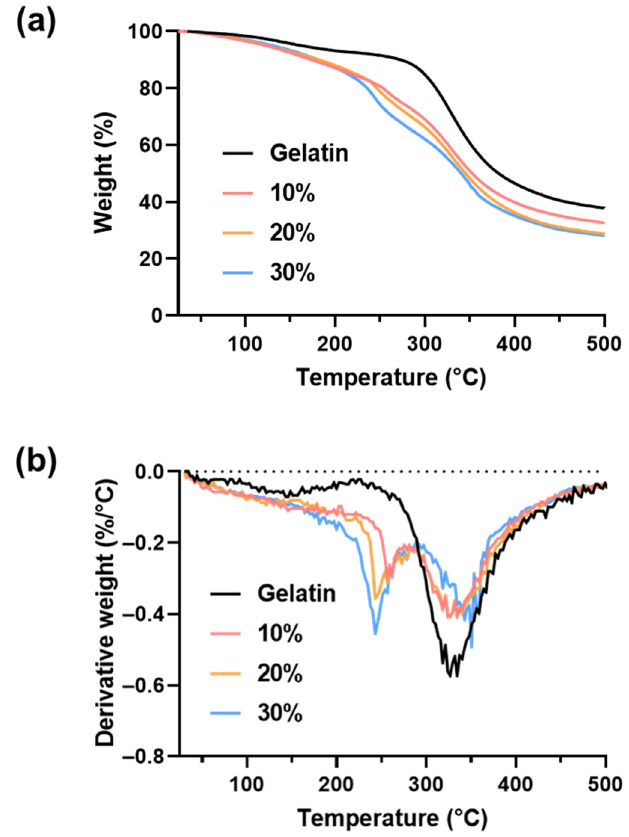
Figure 5. Thermal decomposition of gelatin and furfuryl-gelatin hydrogels. ( a ) Thermogravimetric (TG) curves. ( b ) Derivative thermogravimetric (DTG) curves.